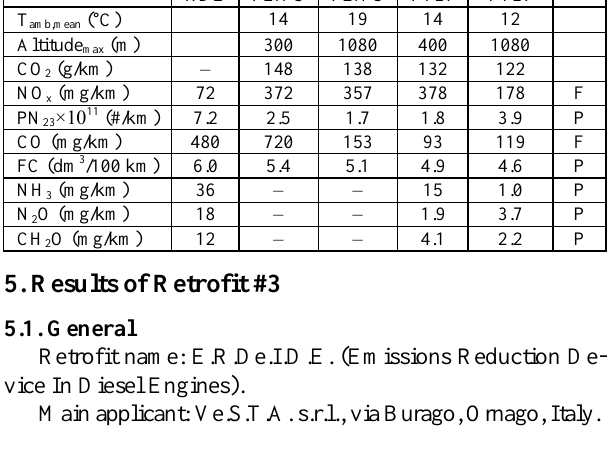
Table 6. On-road emissions. F = Fail, P = Pass based on the Engine limits because the prototype vehicle was delivered for the Engine prize (Table 1). Lim. = Limits